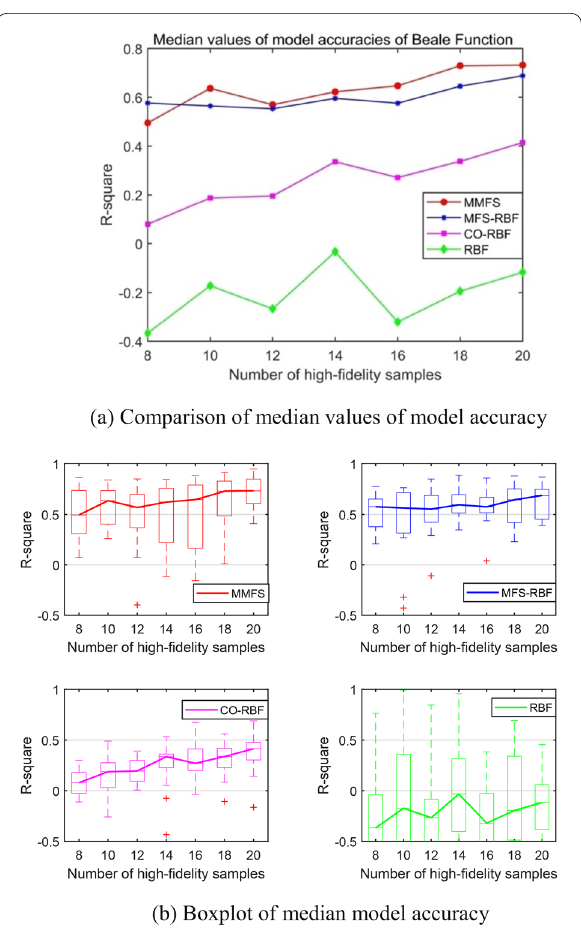
Figure 7 Comparison of median model accuracy of Beale function: a Comparison of median values of model accuracy, b box plot of median model accuracy